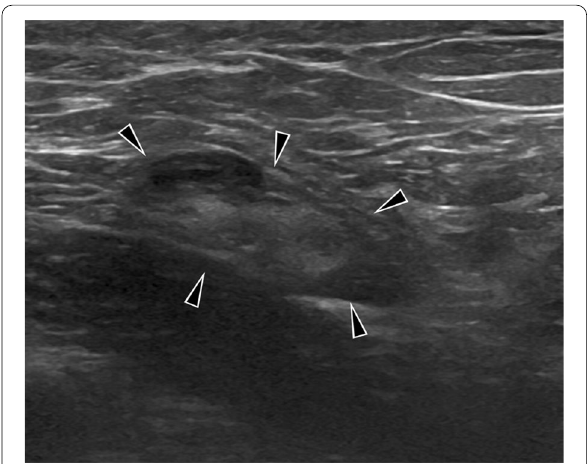
Fig. 7 A 24-year-old and 30-weeks pregnant female patient. Ultrasound images show parenchymal edema in the right breast and abscesses with dense content (arrowheads), fistula tracts (arrows), and thickening of the skin (curved arrow). BIRADS